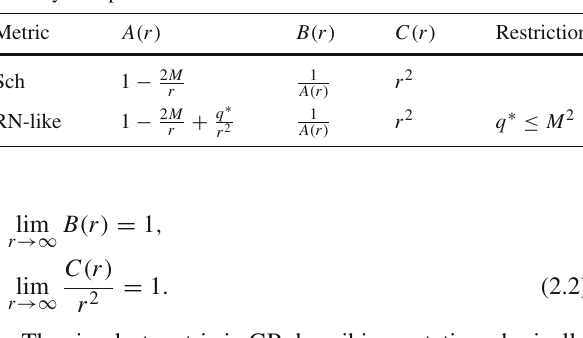
Table 1 Family of metrics around compact objects with a gravitating mass M and a charge q ∗ , in static, spherically symmetric and asymp- totically flat